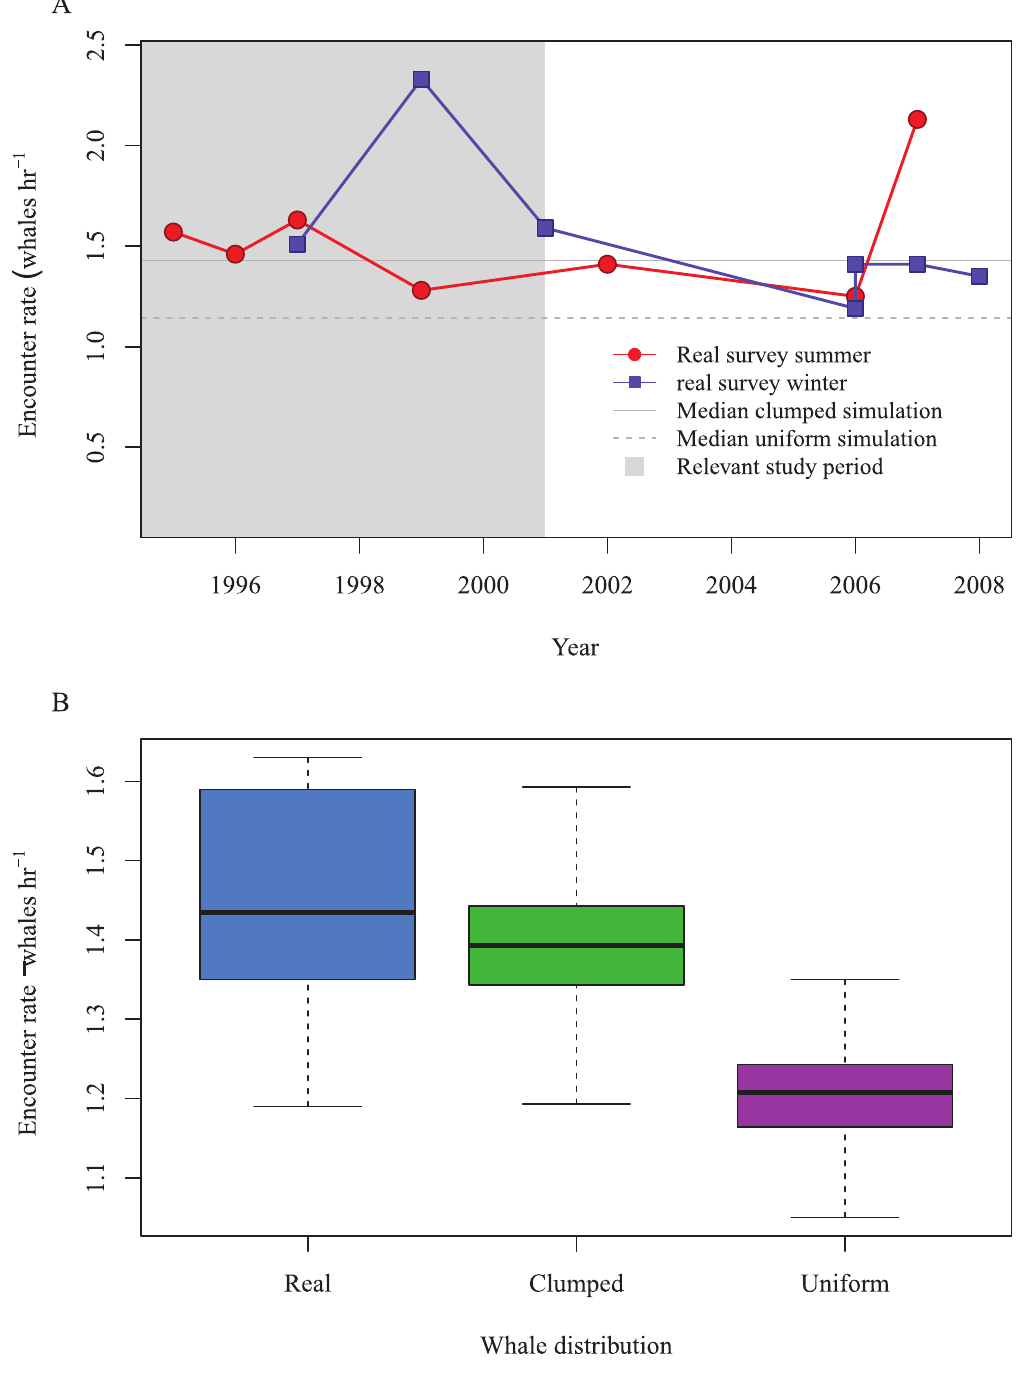
Figure 4. Results from simulation of Kaikoura sperm whales. (A) Encounter rates of sperm whales in Kaikoura observed in the summer (red line) and winter (blue line). The solid horizontal line denotes the median simulated encounter rate for a given clumped whale distribution, and the dashed line, the median of the uniform distributed whale simulation. The solid gray rectangle denotes the period of the data for which the number of resident whales used in the simulation was derived [31]. (B) Comparison of seasonal variance of estimated encounter rate for real data, simulation with clumped and uniform whale distribution. doi:10.1371/journal.pone.0095602.g004 whale distribution and density. Extrapolating the validation to an modelling complex surveys, rather than a validation of specific ocean-wide low density population is not ideal. However, the parameters/modelling. validation is applicable for the simulation concept and idea of Of necessity, the simulation makes several simplifications and omissions. For example, the decision rules do not capture the